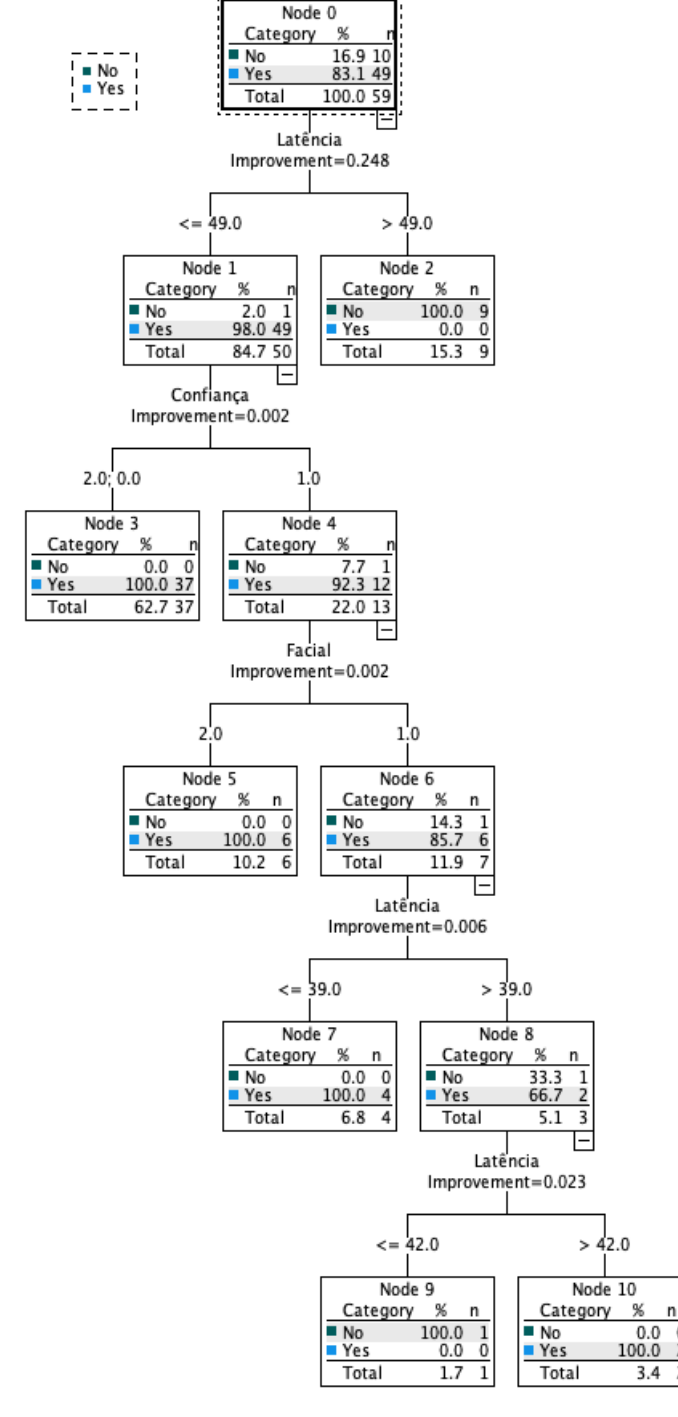
Figure 1. Decision Tree.